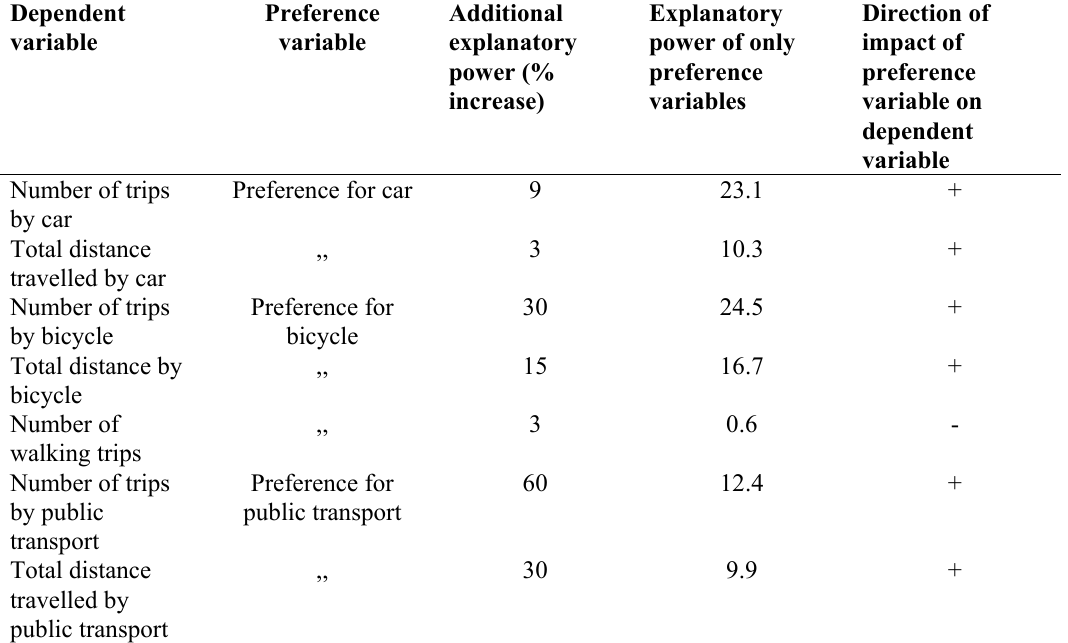
Table 3. Results of analyses showing additional explanatory power of preferences in multivariate regression